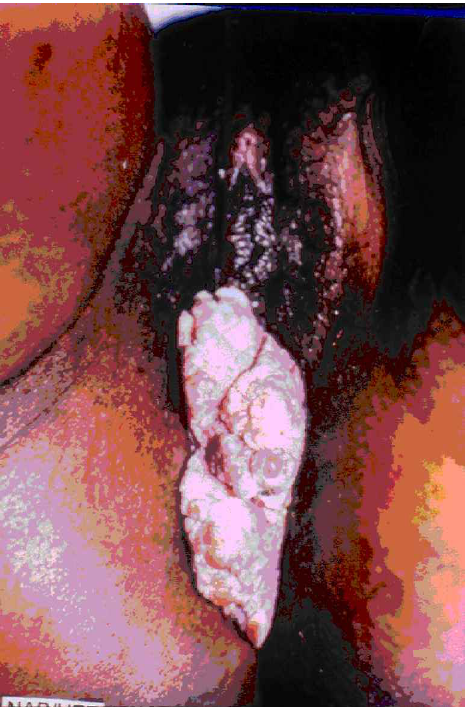
Figure 6 Case 2; as the lesions did not completely regress, the option was taken for surgical excision under local anesthesia